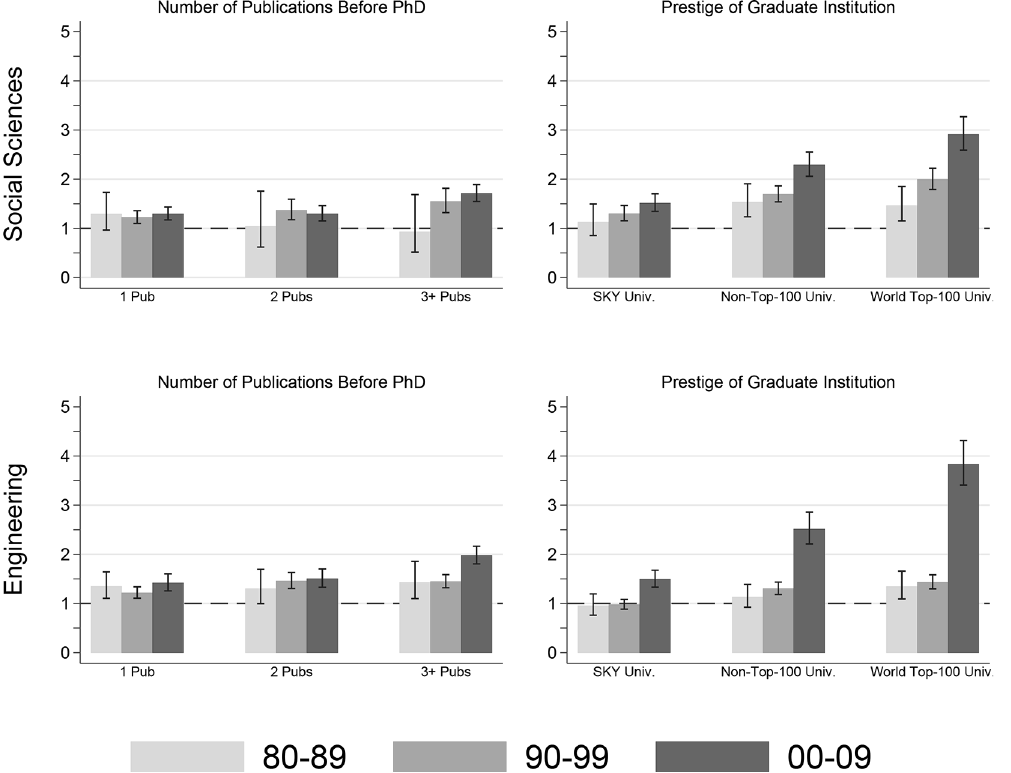
Fig 4. Odds Ratios from the Discrete-Time Event History Regression of Entry into the Academic Career on Selected Independent Variables, by Doctoral Cohorts: Social Sciences and Engineering. Values greater than 1.00 indicate a positive association, while values less than 1.00 indicate a negative association. Error bars are 95% confidence intervals. All models control for gender (female), age at receipt of doctorate, years between baccalaureate and doctorate, prestige of undergraduate institution, academic discipline, year at observation, time, and time squared. doi:10.1371/journal.pone.0141428.g004 PLOS ONE | DOI:10.1371/journal.pone.0141428 October 28,